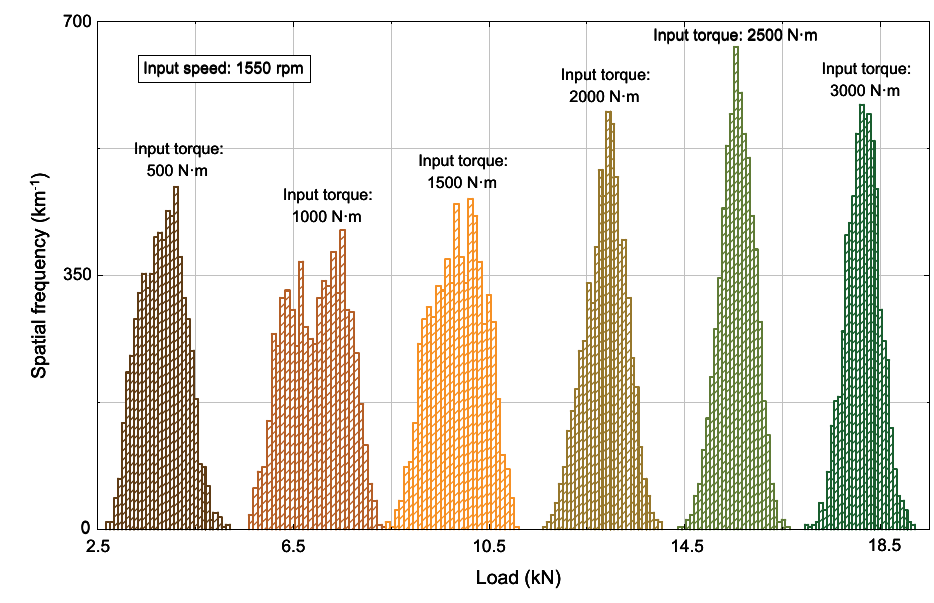
Fig. 9 Frequency distribution histograms of the measured bearing load under different torque conditions of gear meshing (input speed: 1550